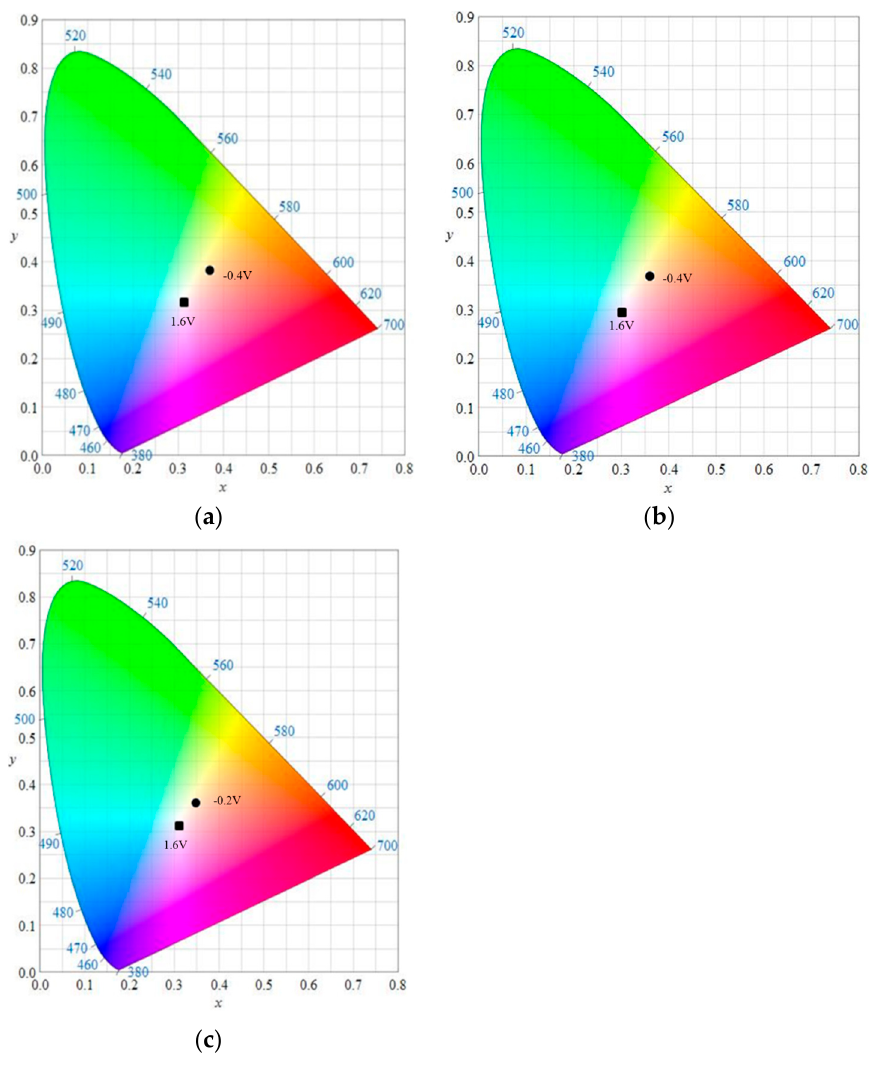
Figure 5. CIE chromaticity diagrams of ( a ) PMPS film in [EPI + ][TFSI − ] solution at − 0.4 V ( ● ) and 1.6 V ( ■ ); ( b ) PMPO film in [EPI + ][TFSI − ] solution at − 0.4 V ( ● ) and 1.6 V ( ■ ); and ( c ) PANIL film in [EPI + ][TFSI − ] solution at − 0.2 V ( ● ) and 1.6 V ( ■ ).